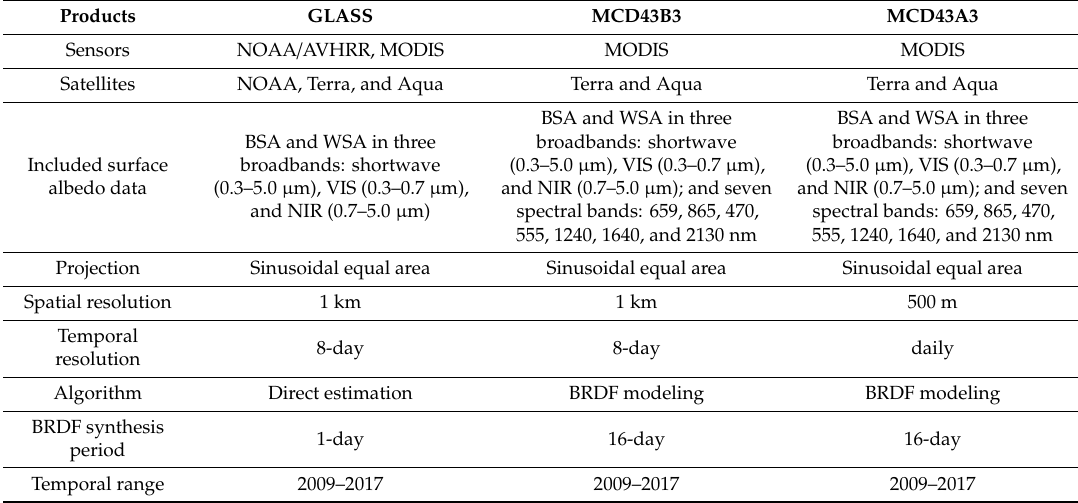
Table 1. Features of the surface albedo products of Global LAnd Surface Satellite (GLASS), MCD43B3, and